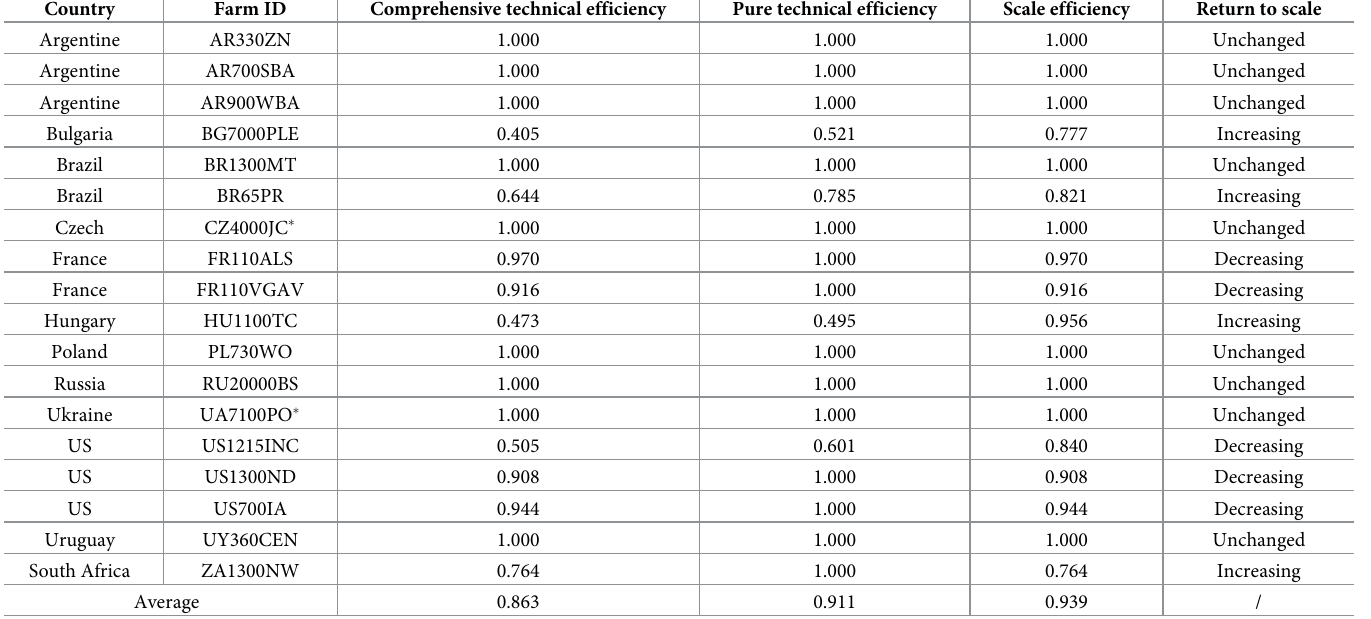
Table 4. Average corn production efficiency and return to scale of typical